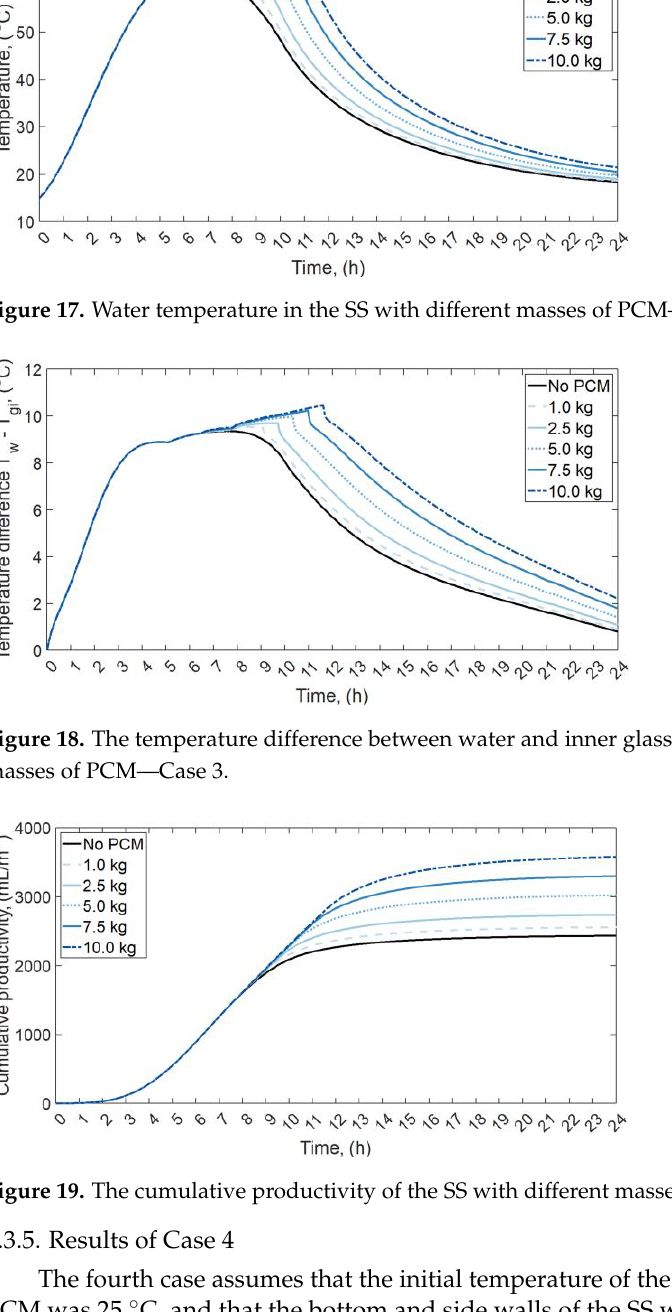
Figure 20. Water temperature in the SS with different masses of PCM — Case 4.